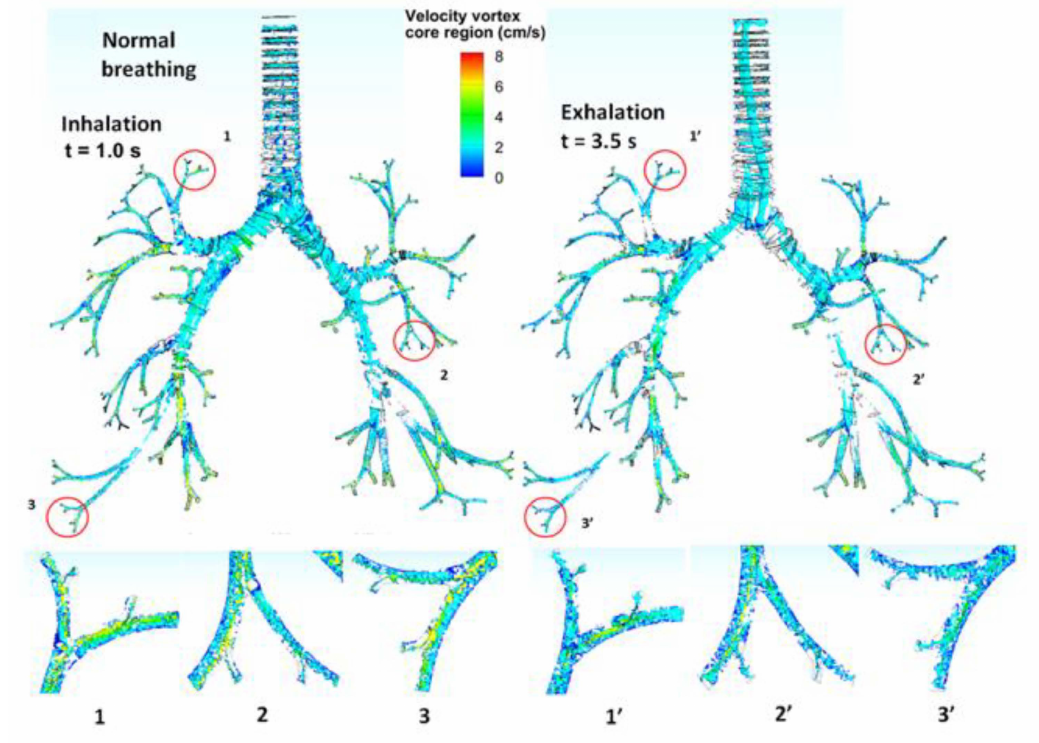
Figure 7. Turbulent spot prediction for Normal Breathing: Vortices through iso-surface during inhalation (t = 1.0 s) and exhalation (t = 3.5 s) for normal breathing with highlighted local bifurcations. Selected local bifurcations are two from right lung and one from left